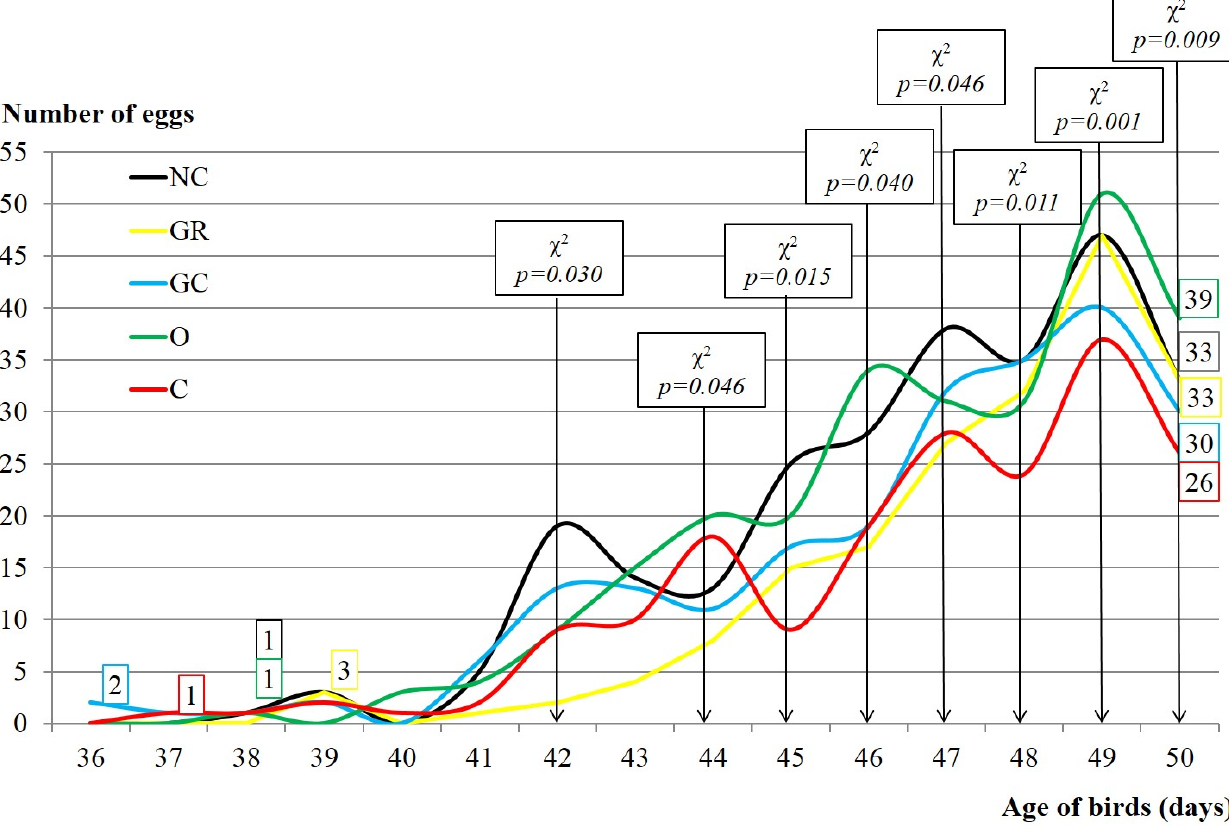
of 0.1 mL each. The size of the dose had to be limited due to the small capacity of the air cell in the quail